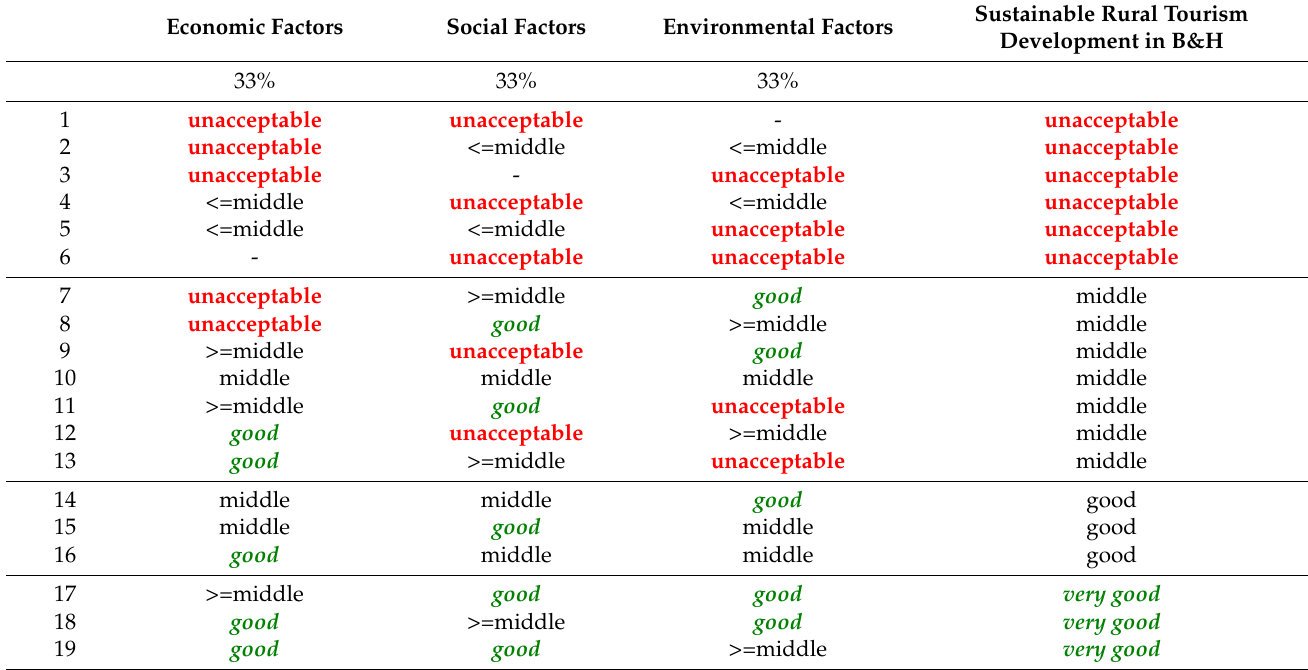
Table 1. Decision